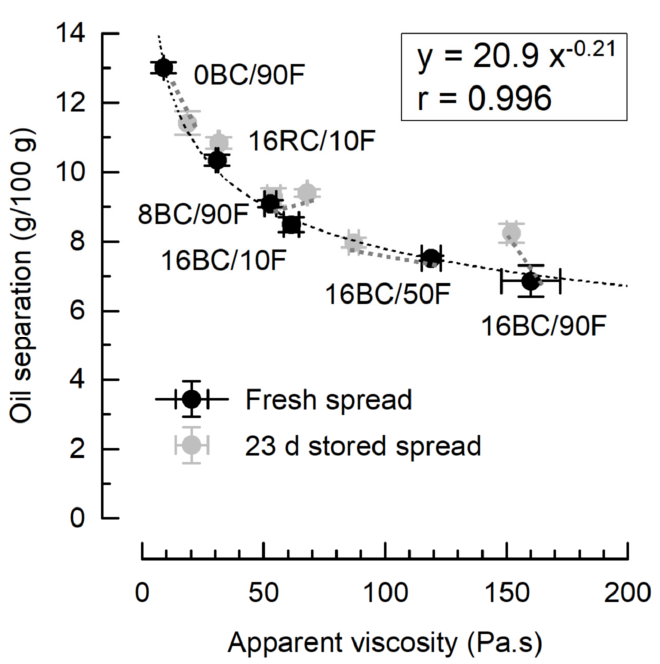
Figure 4. Oil separation at 25 °C and apparent viscosity (at 10/s) of sweet spreads as affected by storage. Coding refers to pomace content (g/100 g), pomace variety (BC—blackcurrant; RC—redcurrant), and the ratio of palm fat (F) related to total fat (%).